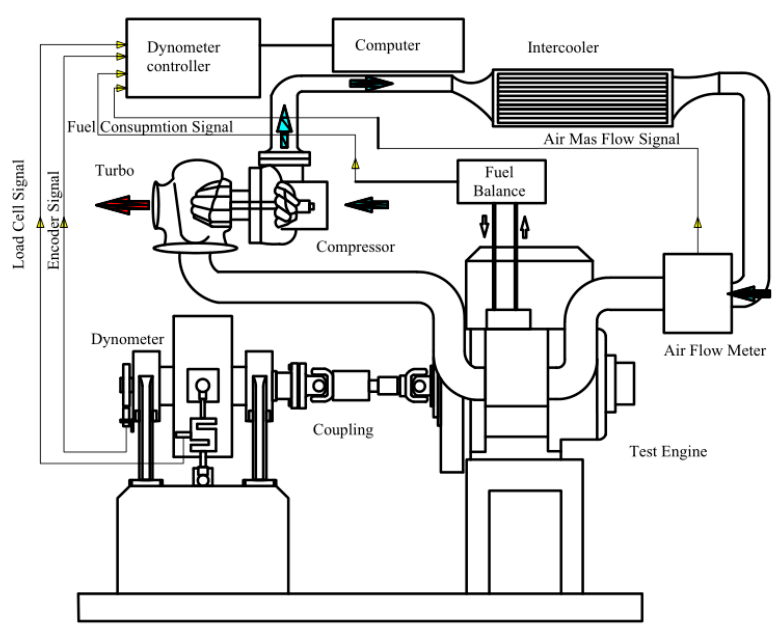
Figure 1. Schematic of the experimental procedure.